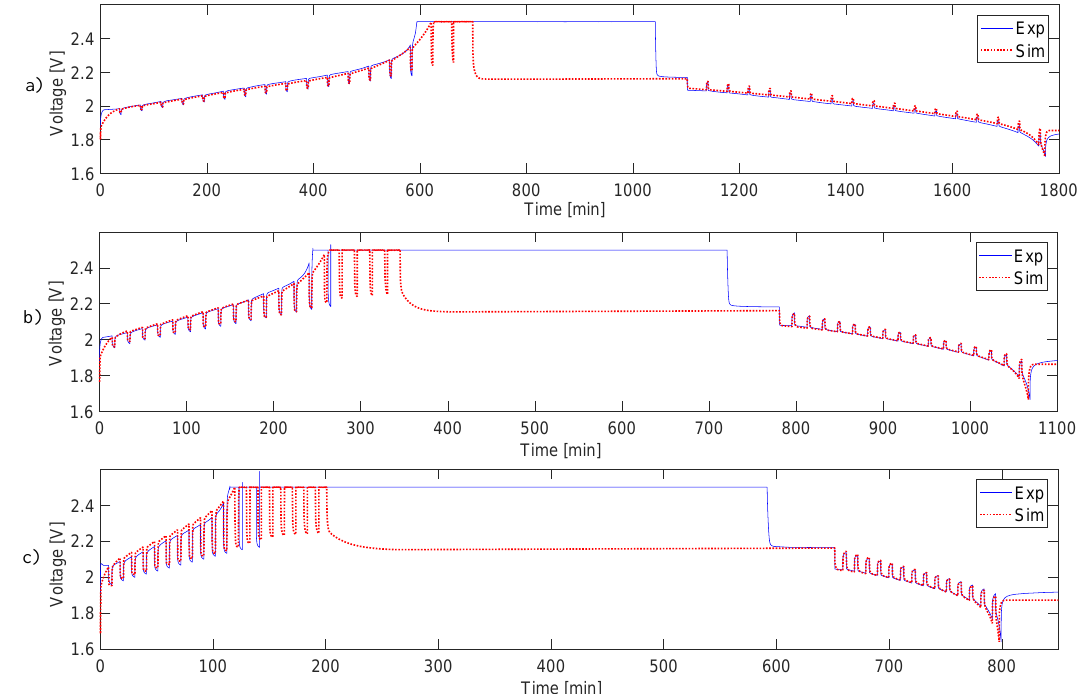
Figure 13. Comparison of experimental result and simulation result-VRLA battery: ( a ) test with 0.1 C; ( b ) test with 0.25 C; and ( c ) test with 0.5 C.